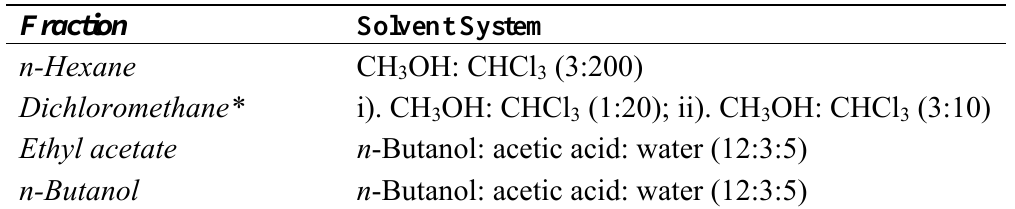
Table 4. Solvent Systems for Dodonaea viscosa